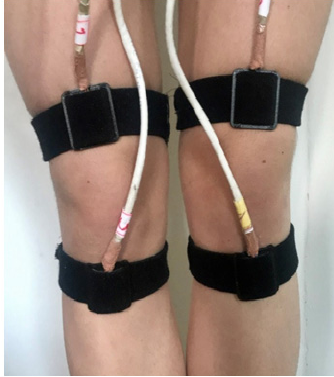
Figure 3. Attachment positions of the four accelerometers. Four accelerometers were attached medially to the distal femur and proximal tibia of both legs.